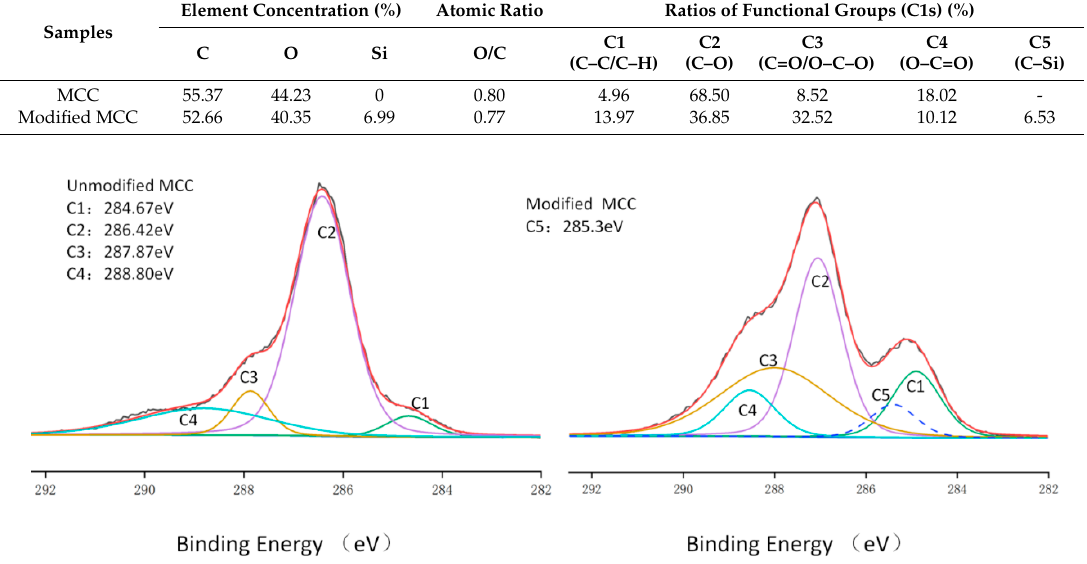
Table 4. The surface elements and functional groups distribution of MCC determined by XPS.